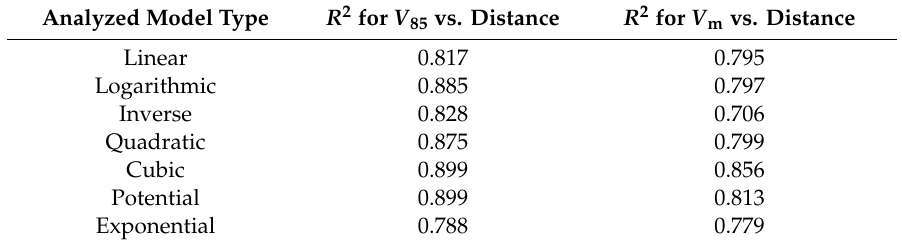
Table 3. Summary of analyzed model types to correlate the distance and V 85 and V m and obtained R 2 . Analyzed Model